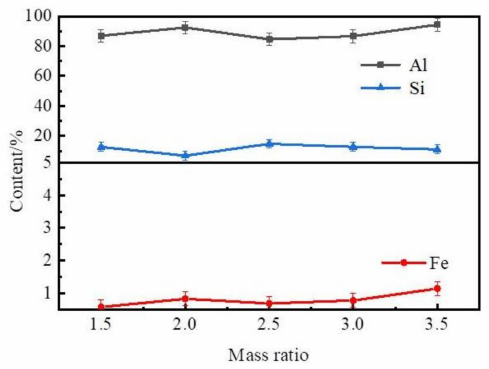
Figure 7. Effect mass ratio on composition of the Al–Si